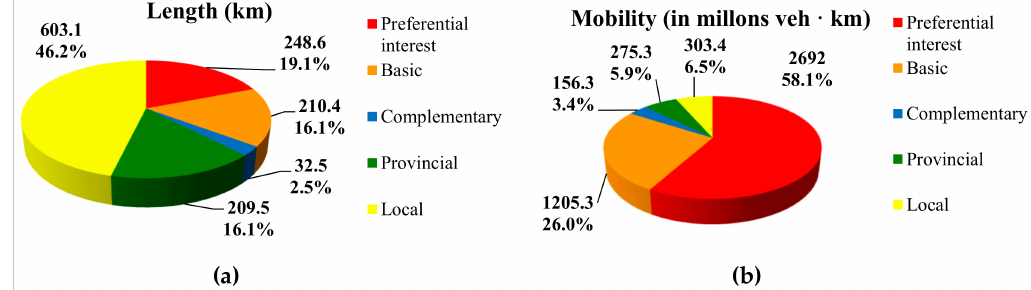
Figure 1. ( a ) Length of each road network level managed by the RGB in 2016; ( b ) Mobility in each road network level managed by the RGB in